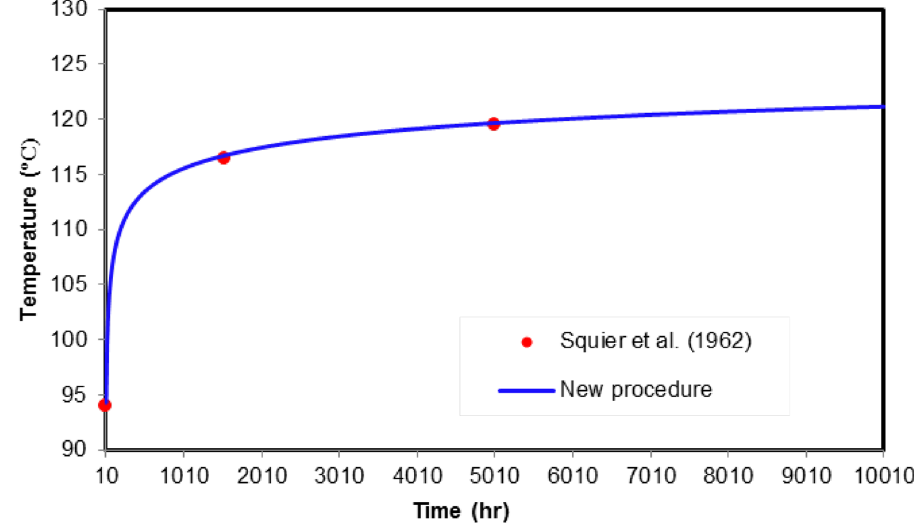
Fig. 5 Comparison of bottom- hole temperature versus time from Squier et al. (1962) with predicted by the new